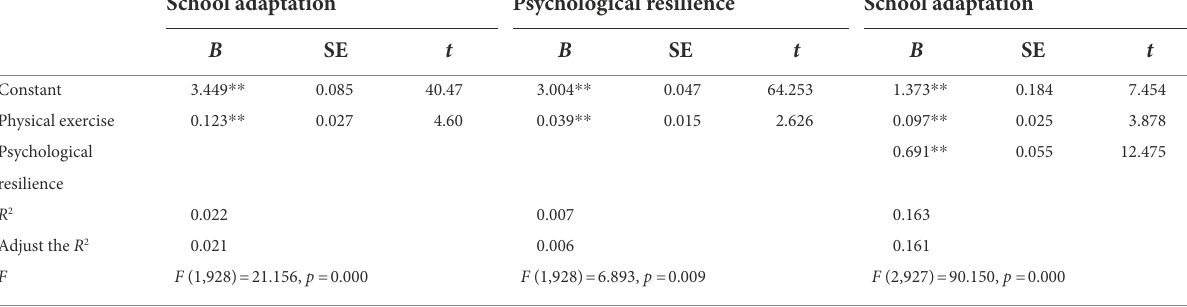
TABLE 4 Analysis results of the mediating effect of psychological